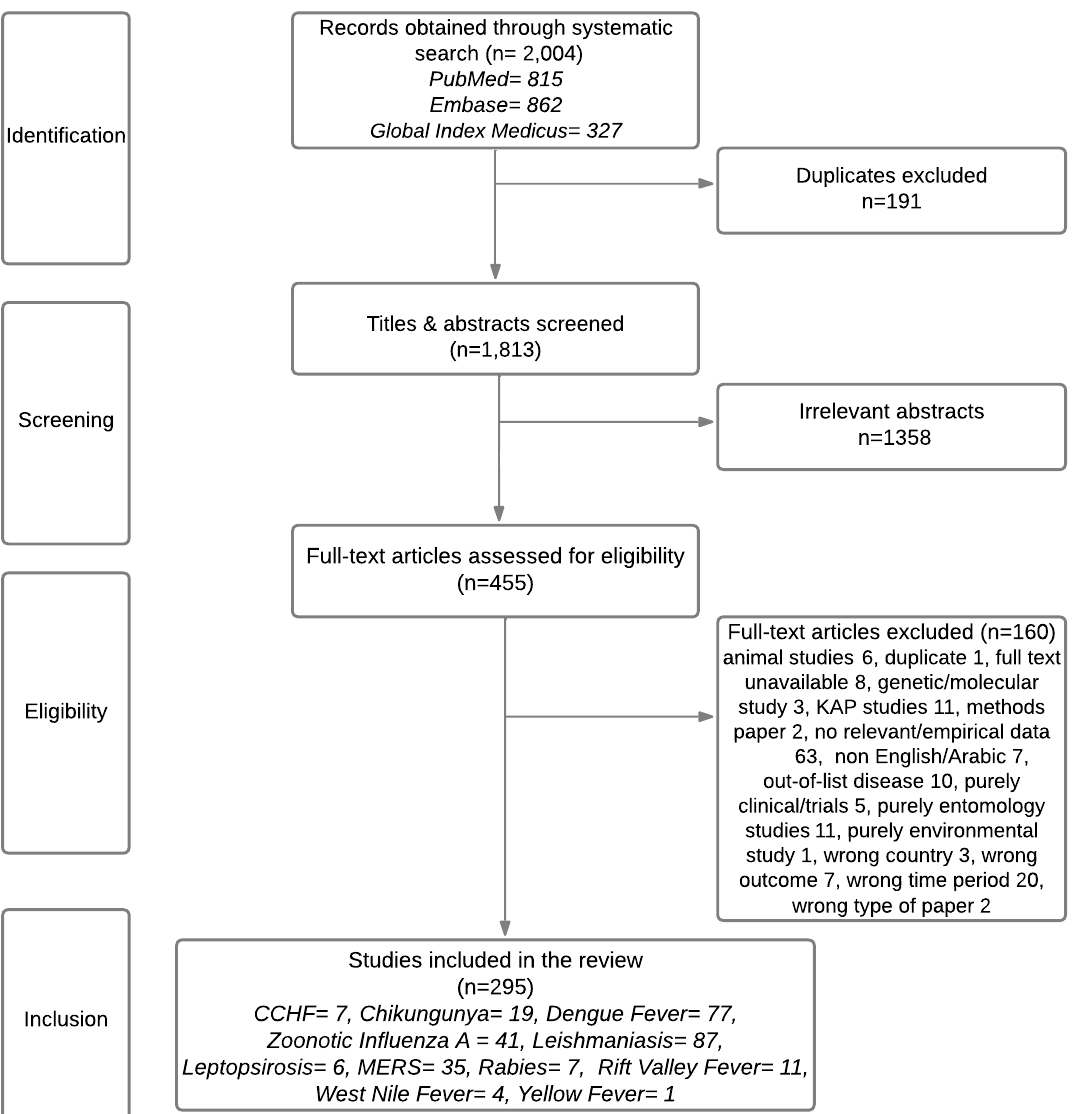
Fig. 1 PRISMA flowchart—review of vector-borne and zoonotic diseases in the Eastern Mediterranean region. CCHF Crimean–Congo hemor- rhagic Fever, MERS Middle East Respiratory